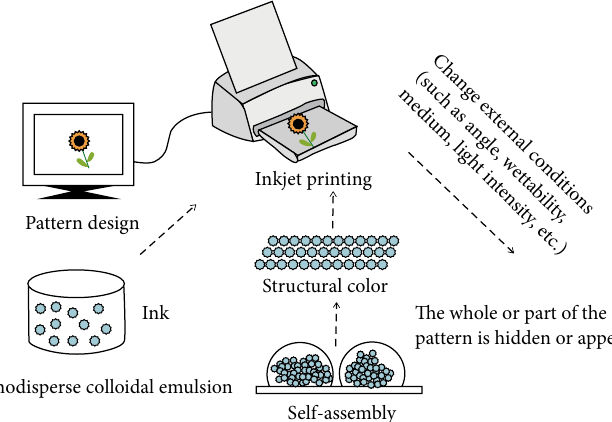
Figure 1: The inkjet printing of photonic